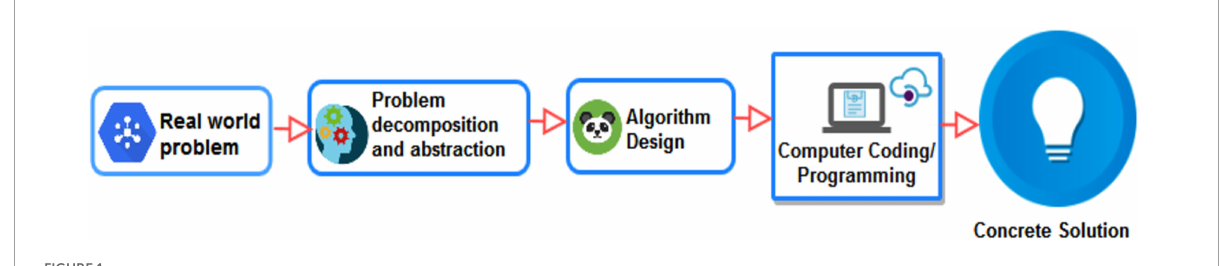
FIGURE1 Features of computational thinking (adapted from Agbo et al.,